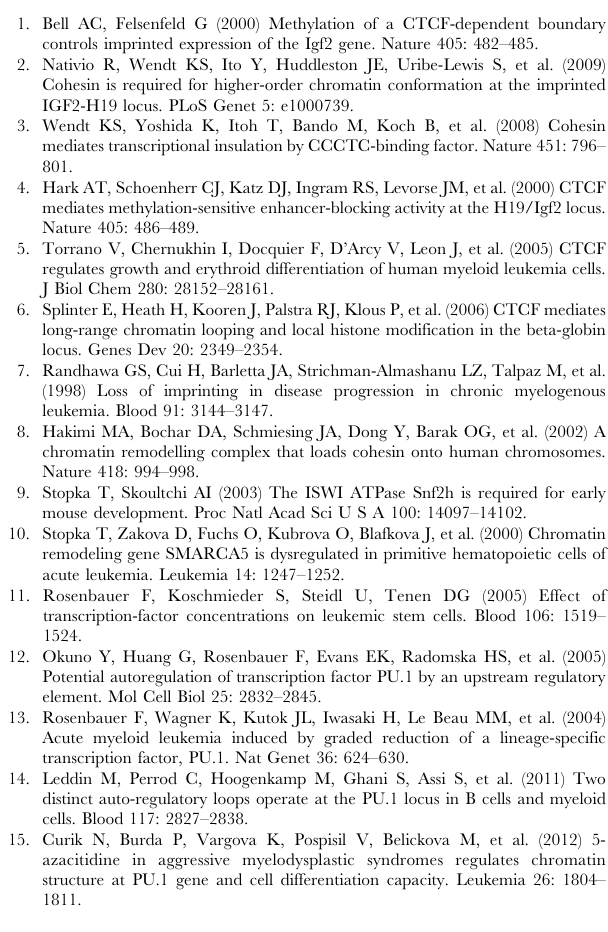
Figure S5 mRNA expression of PU.1 and its target genes in OCI-M2 and normally differentiating mixed myeloid cells (heat map). mRNA from mixed myeloid cells, untreated OCI-M2 and OCI-M2 treated for 72 hrs with GCSF-AZA (see MM) were analyzed by RT-PCR. Y-axis: specific mRNA relative to average of HPRT1 and GAPDH was normalized to untreated OCI-M2. Figure S6 A AZA-mediated DNA demethylation in untreated OCI-M2 and AZA-treated OCI-M2. Sequencing of bisulphite- treated DNA was performed over the regions 2 15.6 kb, 2 14.4 kb and 2 11.0 kb of SPI1 locus. The primer sequences are shown in Table S2. Each region contains twelve CpGs as indicated below the graphs. B AZA-associated DNA demethylation was performed in CD34 + cells isolated from MDS patient without AZA therapy (N = 1, information in Table S1) and MDS patient after AZA therapy (N = 1). C DNA methylation of normal and AML/MDS CD34 + cells. The DNA was isolated from CD34 + cells of AML/ MDS patients (N= 3) and control donor (N = 1). Y-axis: % of unmethylated CpGs; x-axis: number of CpG. Arrows indicate demethylated CpGs.